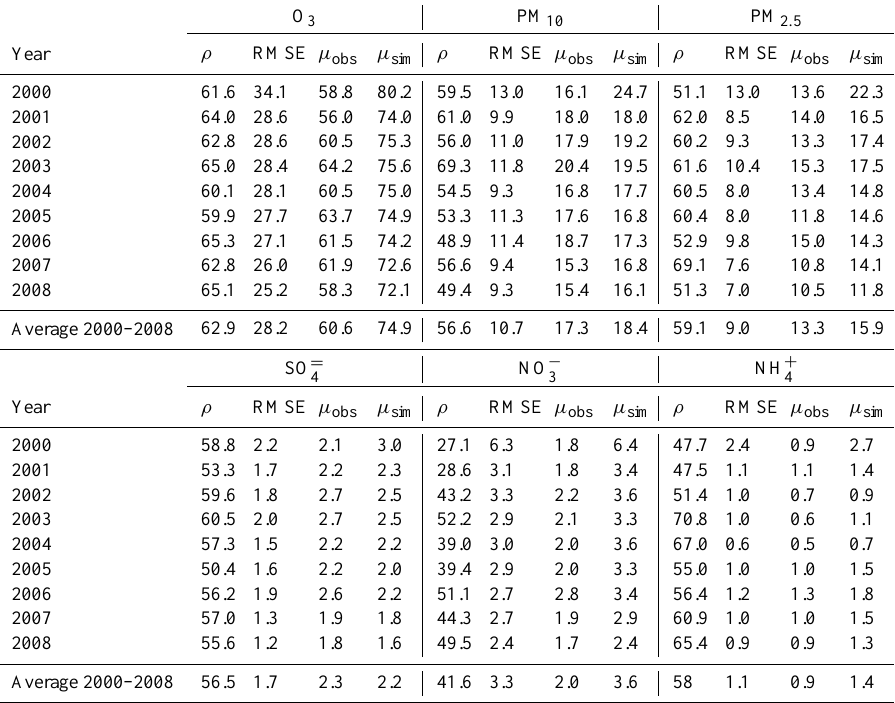
, NO − , and NH + (daily basis). 4 3 4